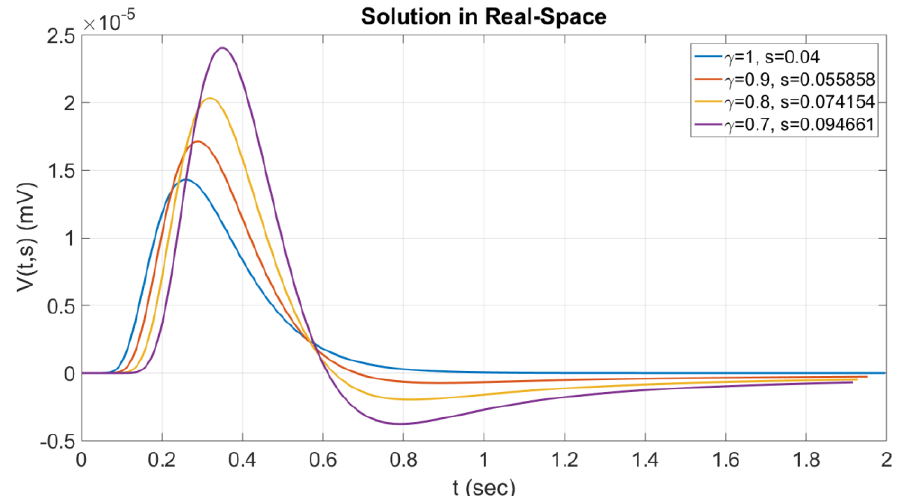
Figure 3. The voltage V(t,s) for various values of fractional order γ and corresponding values of s in real space (S = 0.04).